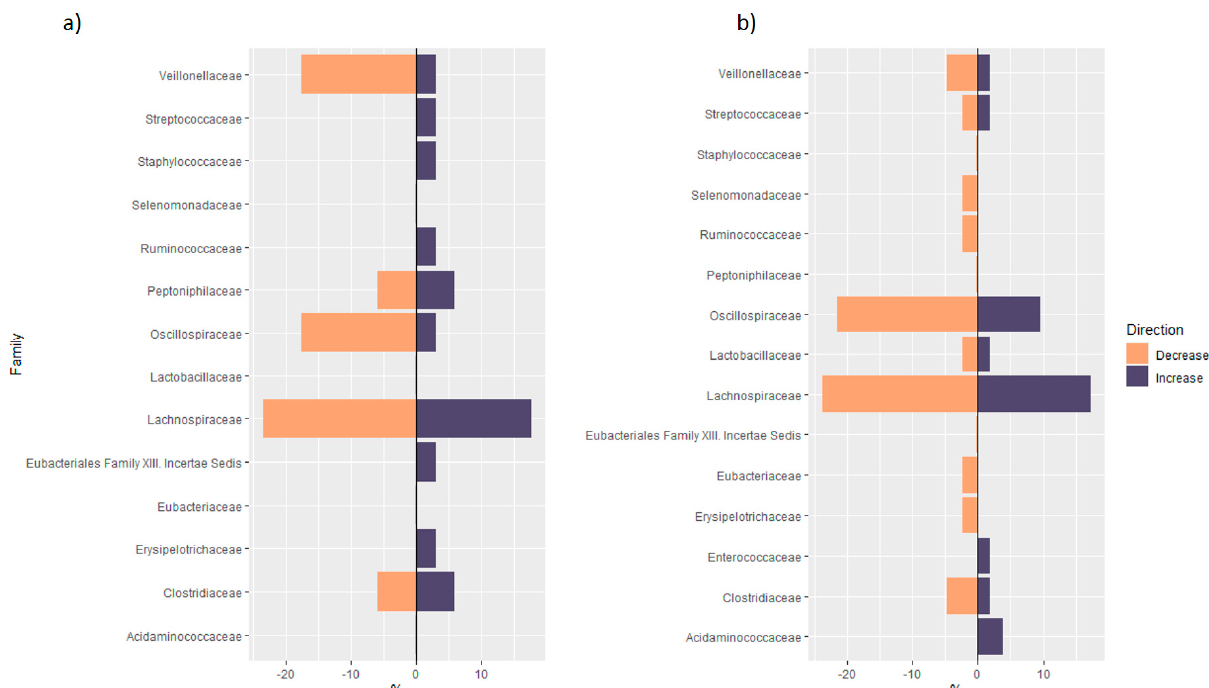
Figure 2. ( a ) mirror bar chart of the number of significant taxa in each family of Firmicutes phylum over the total number of significant taxa in each family of Firmicutes phylum found in the non-supplementation group of studies: for each family, the violet bar indicates the number of significant taxa in the family that increased with increasing levels of VD serum levels or dietary intake, over the total number of significant taxa in Firmicutes that increased with increasing levels of VD serum levels or dietary intake (expressed in percentages); the orange bar indicates the number of significant taxa in the family that decreased with increasing levels of VD serum levels or dietary intake, over the total number of significant taxa in Firmicutes that decreased with increasing levels of VD serum levels or dietary intake (expressed in percentages); ( b ) Mirror bar chart of the number of significant taxa in each family of Firmicutes phylum over the total number of significant taxa of Firmicutes phylum found in the supplementation group of studies: for each family, the violet bar indicates the number of significant taxa in the family that increased after VD supplementation, over the total number of significant taxa in Firmic- utes that increased after VD supplementation (expressed in percentages); the orange bar indicates the number of significant taxa in the family that decreased after VD supplementation, over the total number of significant taxa in Firmicutes that decreased after VD supplementation (expressed in percentages).